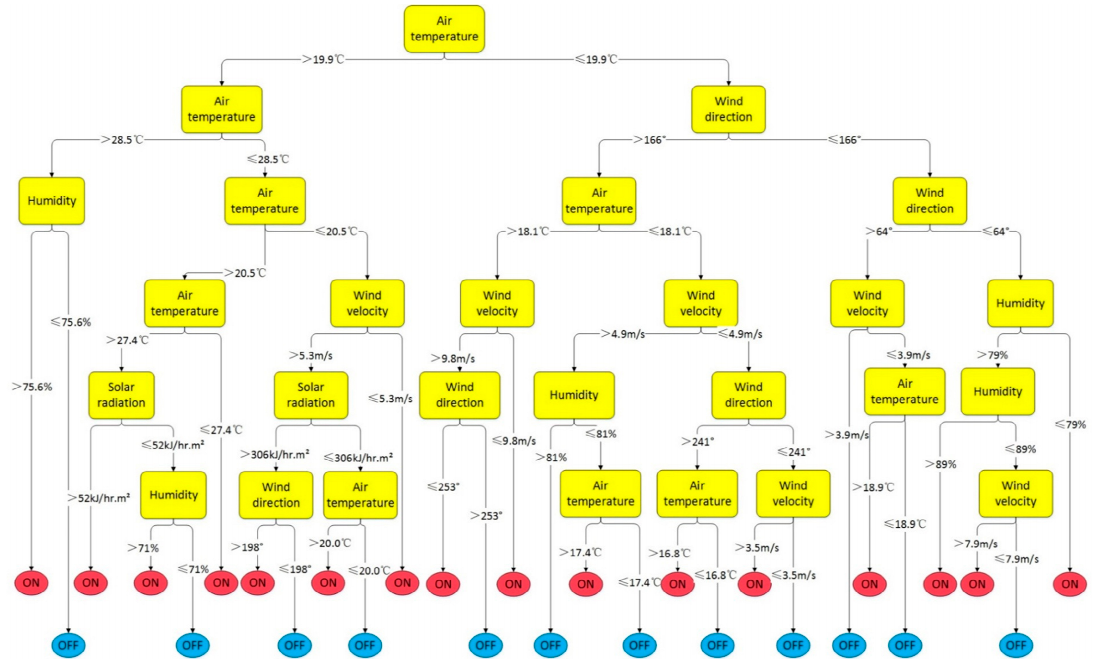
Figure 7. The generated decision tree for ventilation mode selection in Sydney.